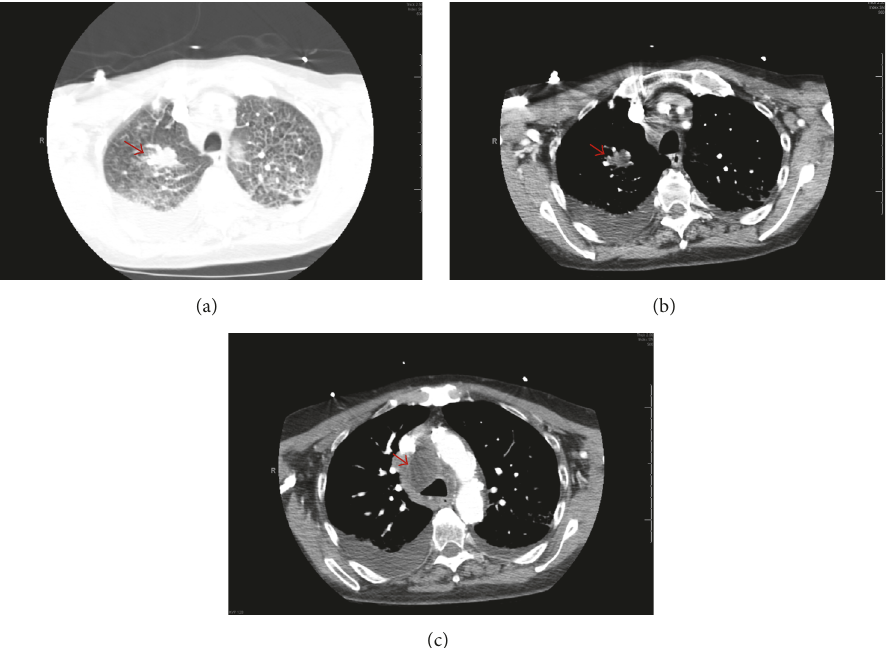
Figure 2: Chest CT with contrast ((a) and (b)): lung window (a) showing right upper lobe 15mm lung nodule (red arrow), pulmonary congestion, and pleural effusion. (b) Mediastinal window showing same. (c) Mediastinal window showing hypodense right paratracheal lymph node of 3.1 cm with (red